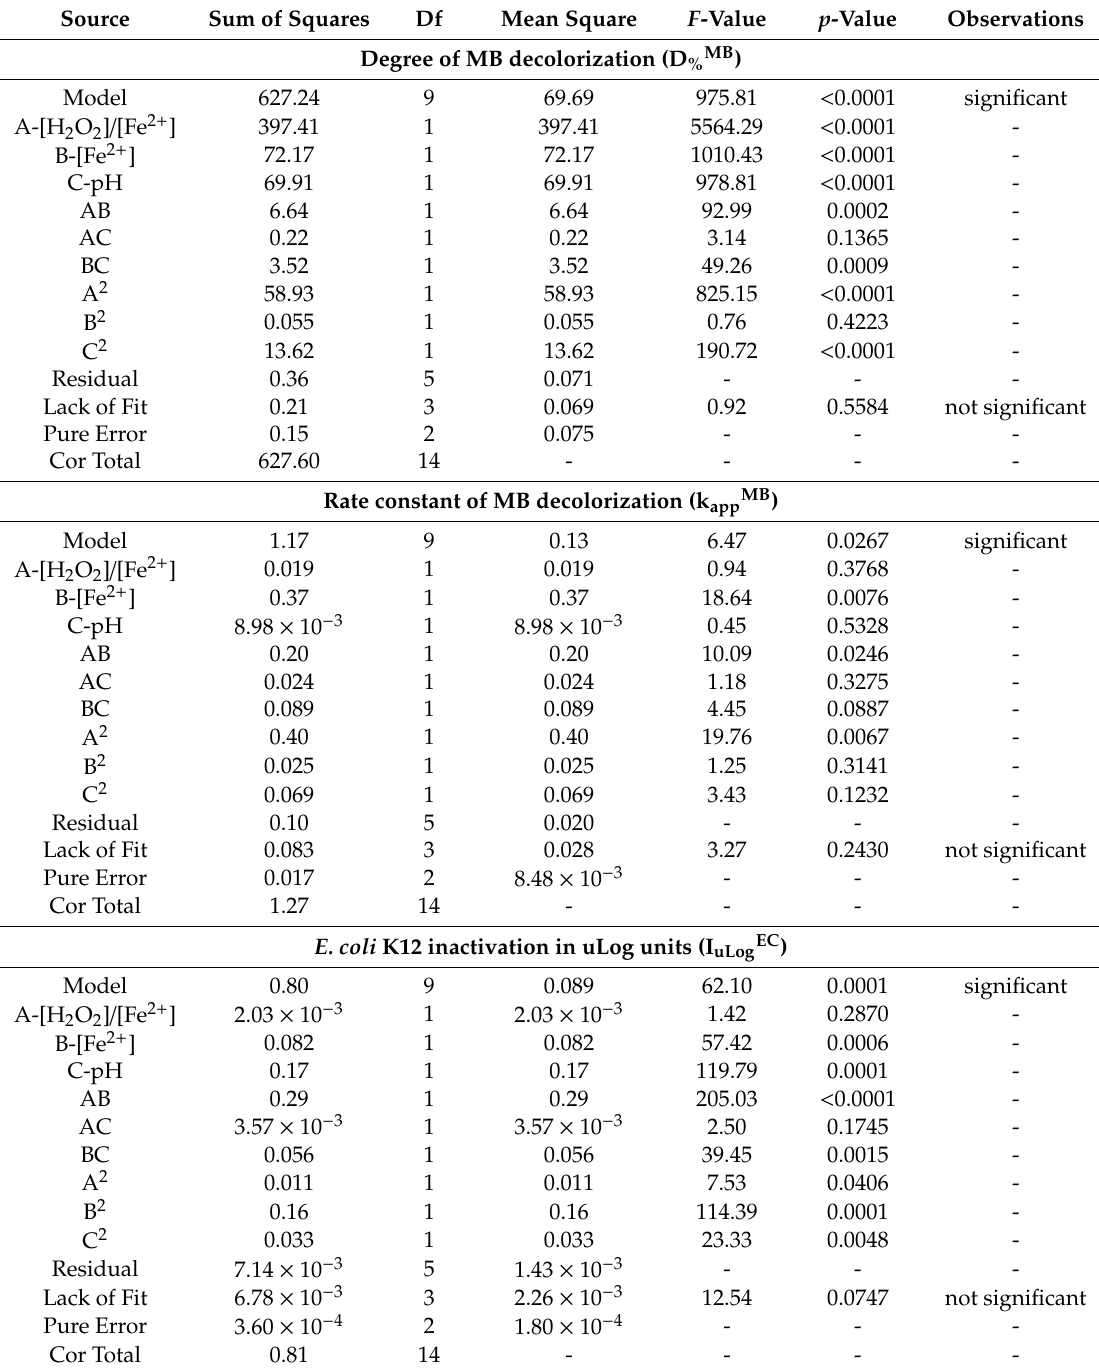
Table 2. ANOVA of the regression model for the prediction of degree of methylene blue (MB) decolorization, rate constant of MB decolorization and E. coli K12 inactivation.